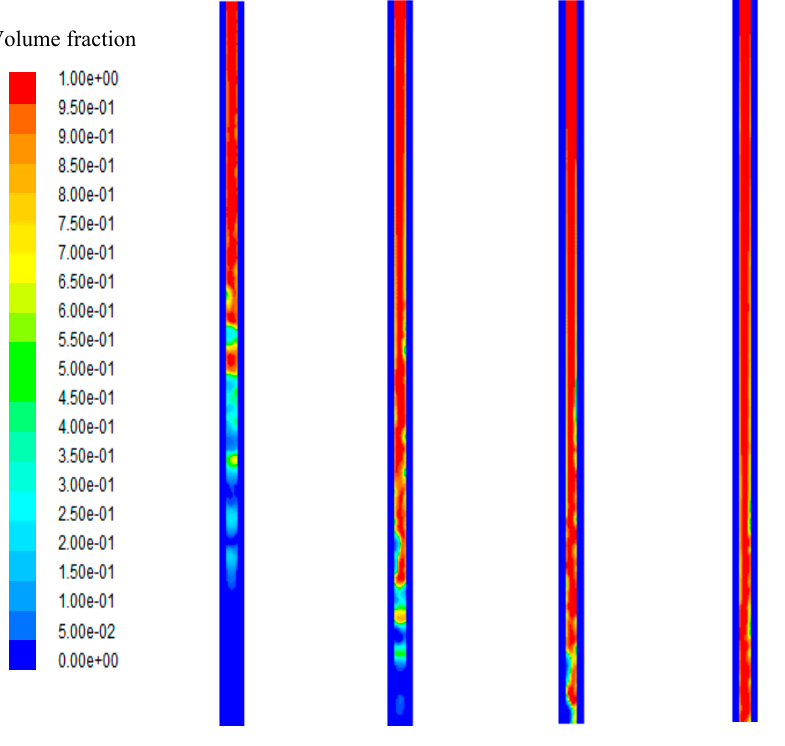
G=10.52kg m -2 s -1 G=37.88kg m -2 s -1 G=78.91kg m -2 s -1 G=109.42kg m -2 s -1 Figure 13. Flow patterns for di ff erent mass flux values and p = 0.65 Figure 13. Flow patterns for different mass flux values and p = 0.65 MPa. Figure 13. Flow patterns for different mass flux values and p = 0.65 MPa.